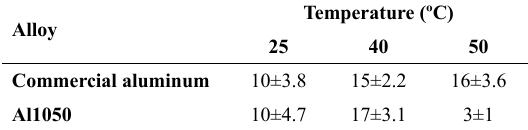
Table 5. Pitting density for alloys at different temperatures after 16 days of immersion in SJ ethanol, in pits per cm 2 (average ± σ). Alloy